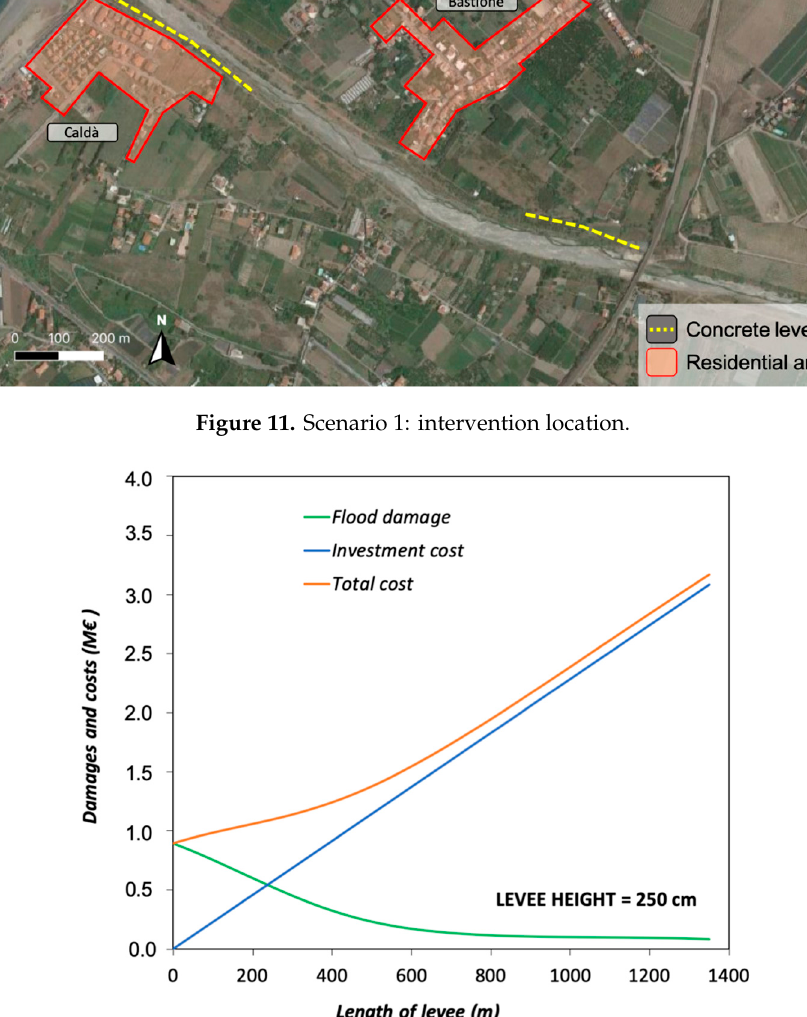
Figure 11. Scenario 1: intervention location.